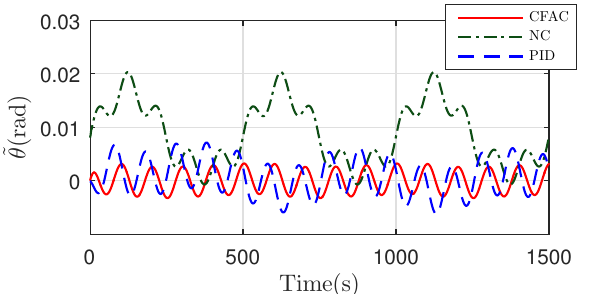
Figure 19. Pitch angle tracking error in floating motion with a variable velocity and constant pitch angle command.